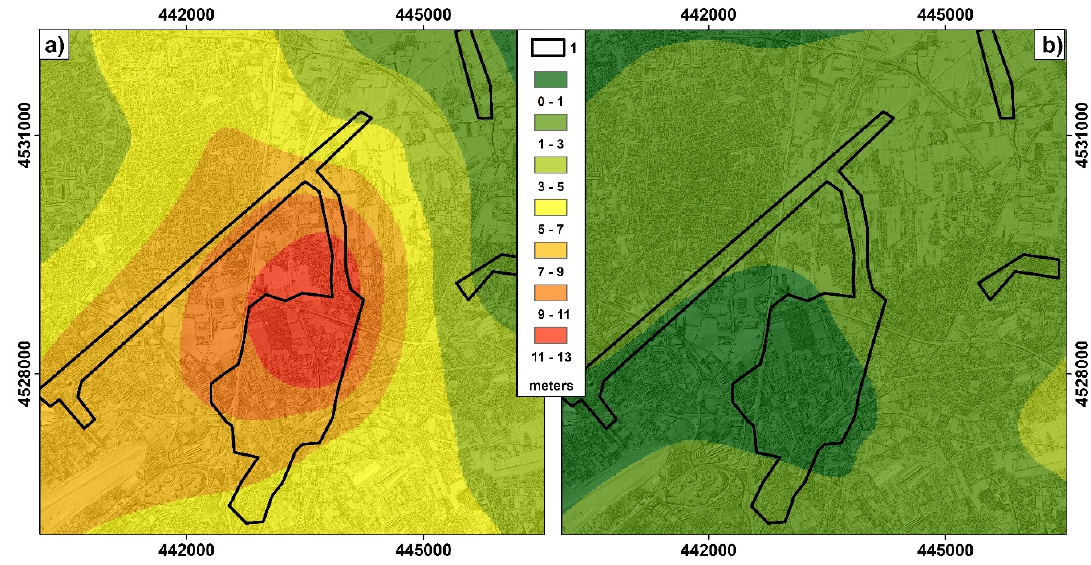
Figure 6. Piezometric level variation (m) in the period 1989–2002 ( a ) and 2002–2006 ( b ). Legend: 1) wells field area. The piezometric variation values were classified using a constant interval of 2 m.